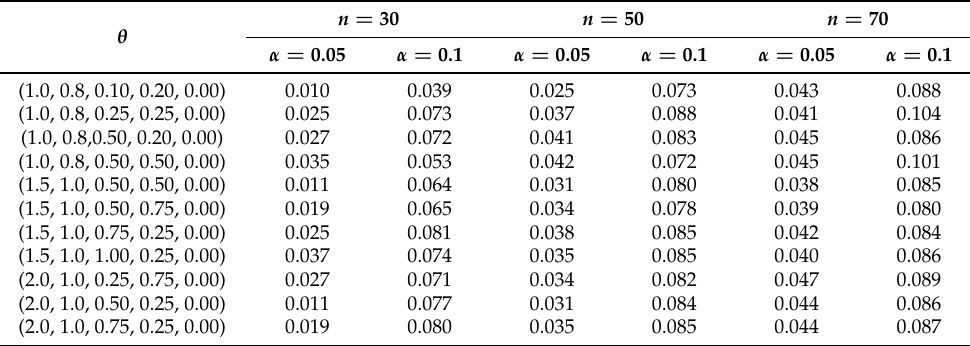
Table 2. Simulation results for the probability of type I error for a 1 = 1 and a 2 = 0.